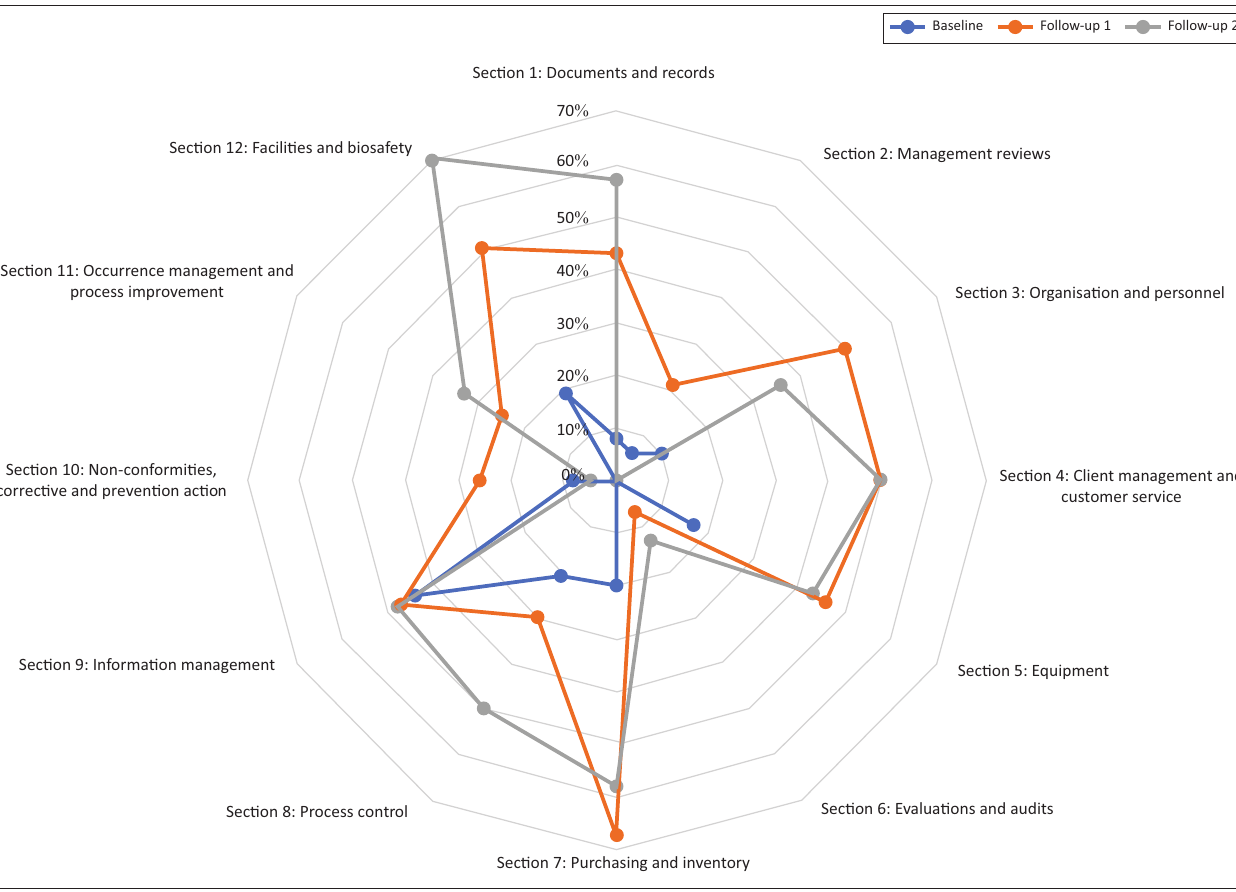
FIGURE 3: Performance of the Army Teaching Hospital – University Teaching Hospital laboratory in each section of the Stepwise Laboratory Improvement Process Towards Accreditation checklist, Benin, 2016-2018. Baseline evaluation, September 2015; Follow-up evaluation 1, January 2016; Follow-up evaluation 2, October